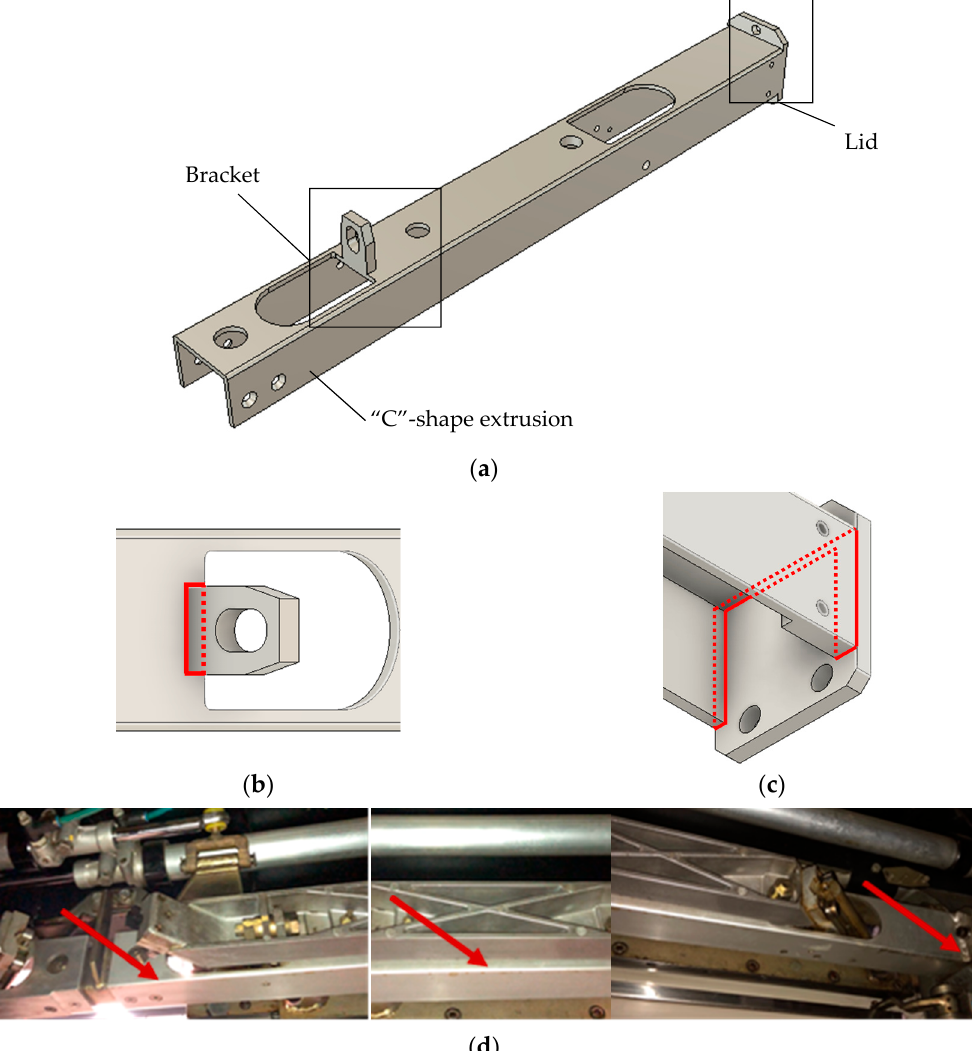
Figure 1. Component used for the study case. ( a ) Extrusion, ( b ) bracket with welding illustration, ( c ) lid with welding illustration and ( d ) location in the wagon.